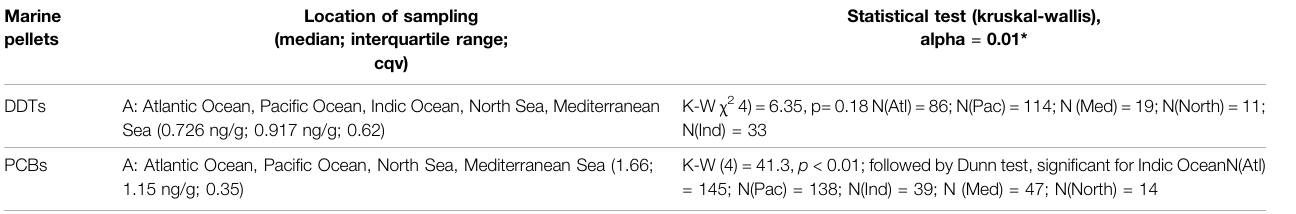
Location of sampling (median; interquartile range;